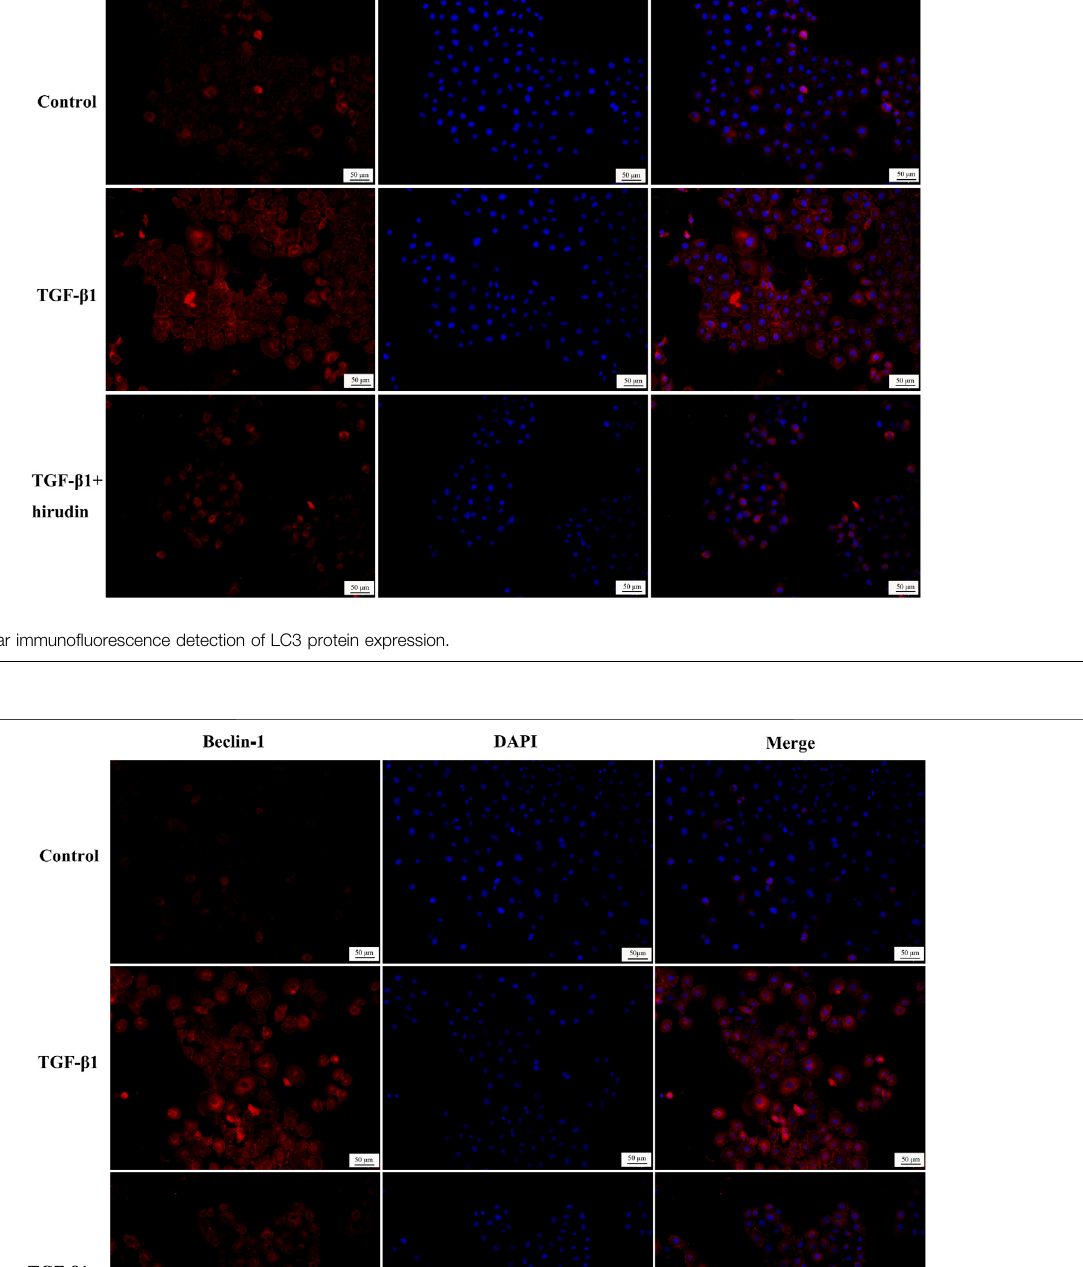
Frontiers in Pharmacology |